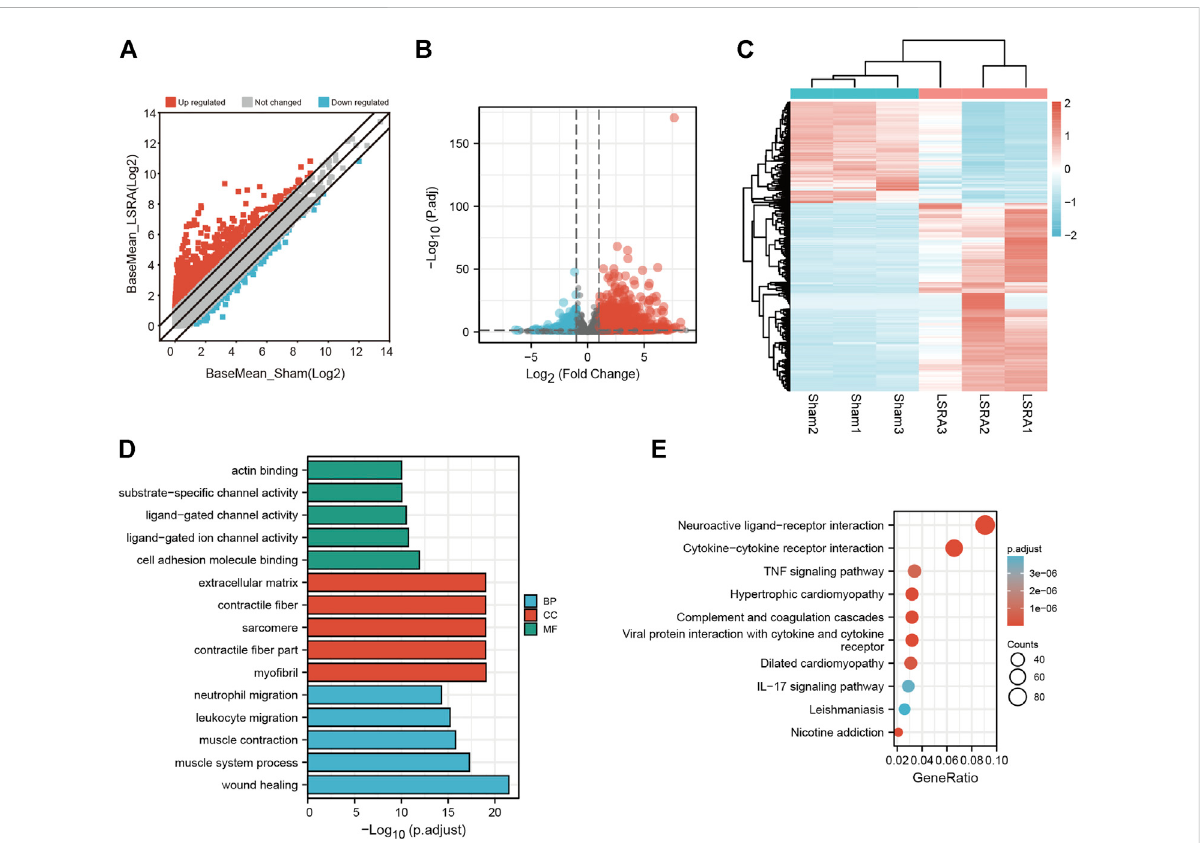
FIGURE 3 Identi fi cation and functional annotation of differentially expressed mRNAs. (A) Volcano plot of mRNA expression between the Sham and LSRA groups. (B) Scatter plot of mRNA expression between the Sham and LSRA groups. (C) Hierarchical clustering analysis of mRNAs that were markedly differentially expressed (|fold change| ≥ 2 and p < 0.05). (D) Top fi ve enriched GO terms for the differential expressed mRNAs. (E) Top 10 enriched KEGG terms of differential expressed mRNAs. mRNAs, messenger RNAs; LSRA, lumbosacral spinal root avulsion; GO, Gene Ontology; KEGG, Kyoto Encyclopedia of Genes and Genomes.